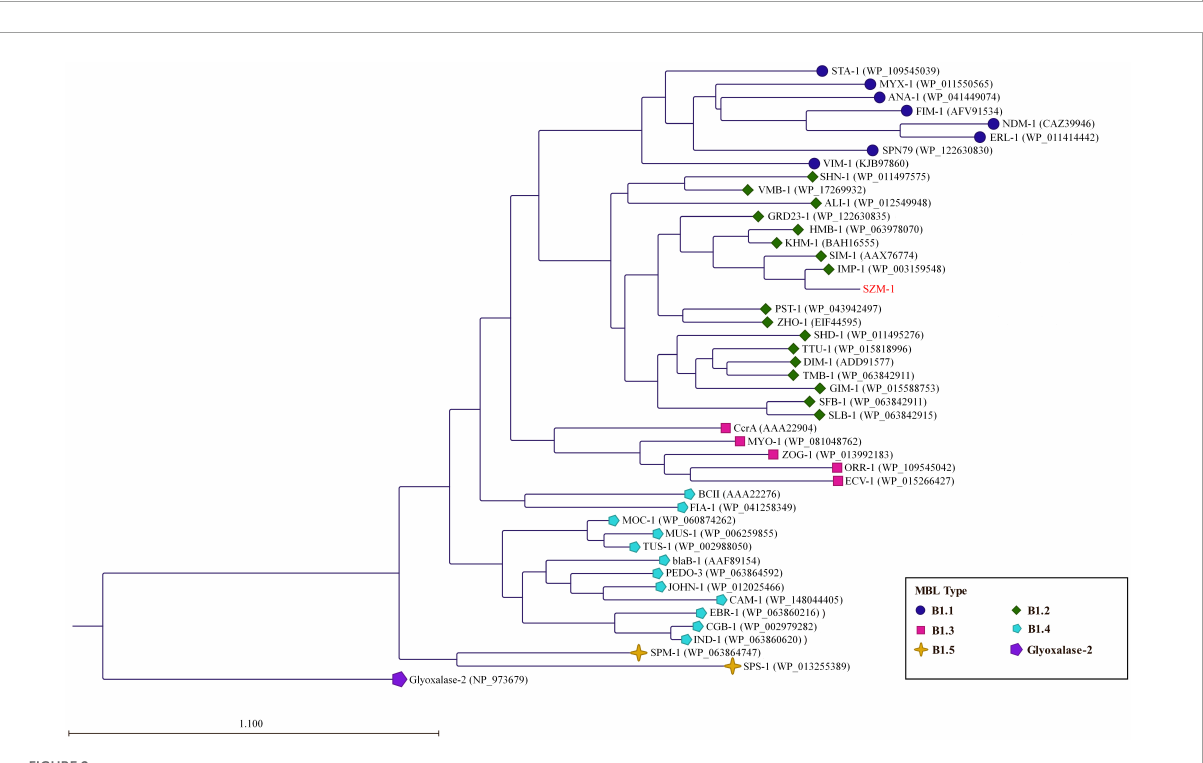
FIGURE2 Phylogenetic analysis of the SZM-1. The phylogenetic tree was constructed with amino acid sequences of the representative MBL B1 subclasses (B1.1–B1.5) and Glyoxalase-2 (used as an outgroup). The tree was created by the Neighbor-Joining method (protein distance measure model: Jukes-Cantor; protein substitution model: WAG; bootstrap replicates: 1000). The horizontal bar indicates the number of amino acid substitution for